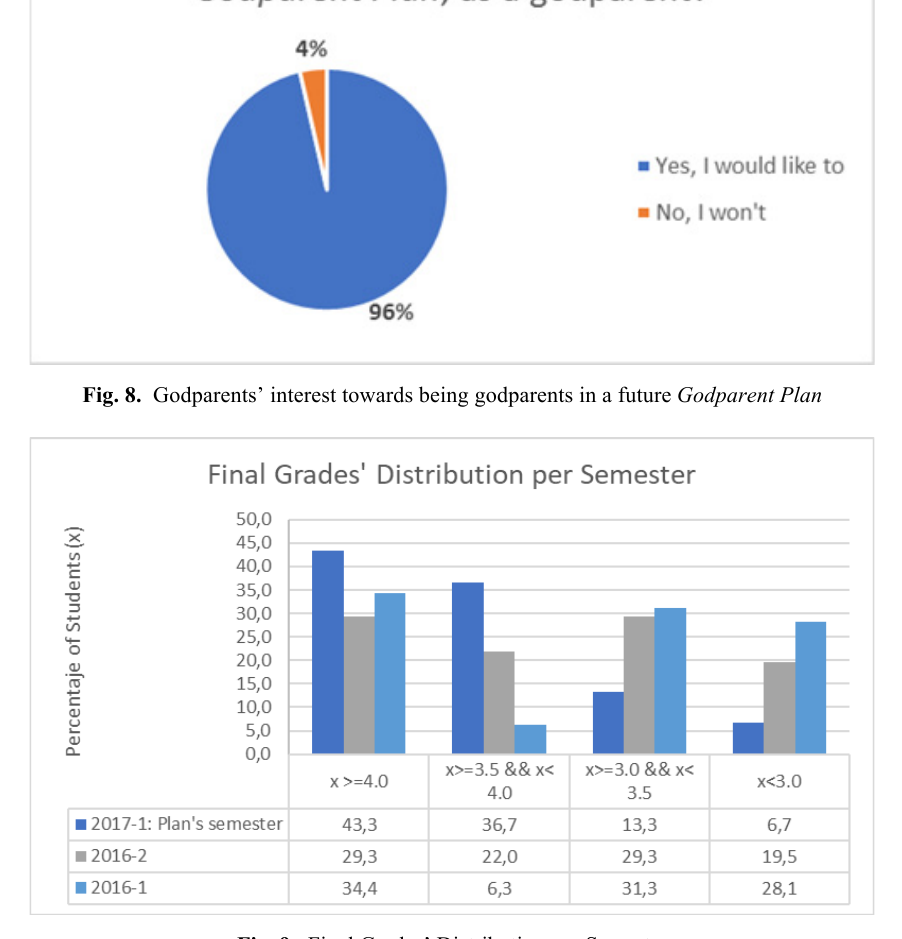
Fig. 9. Final Grades’ Distribution per